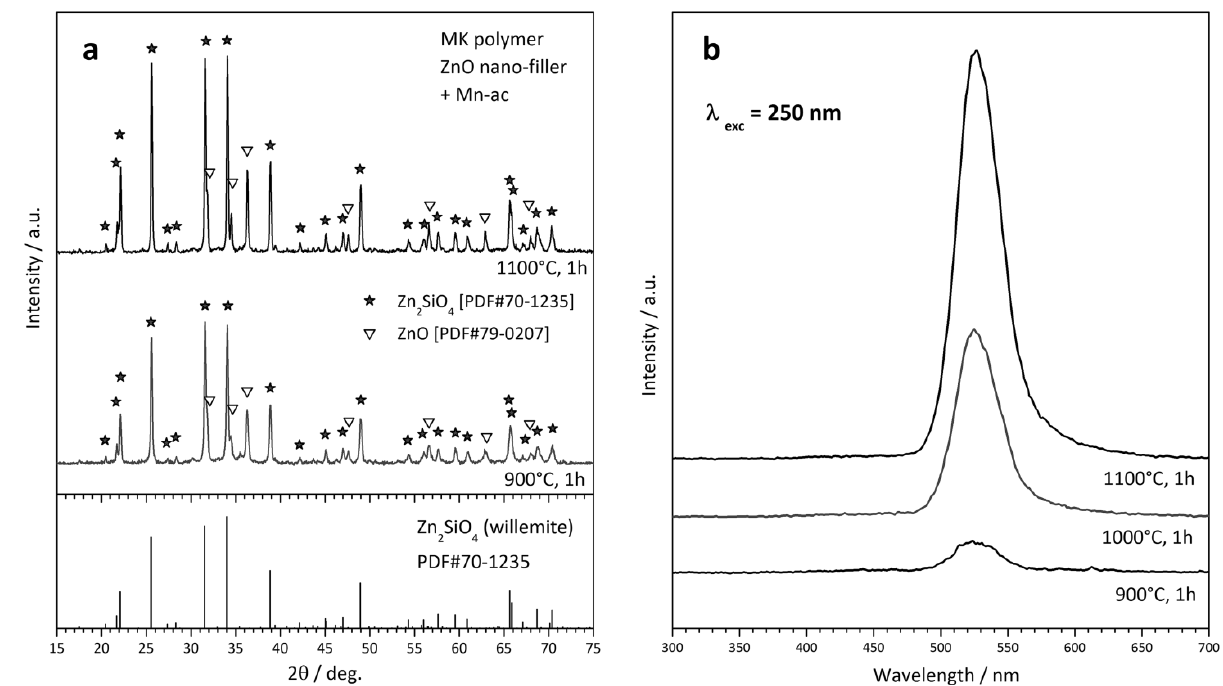
Figure 6. X-ray diffraction patterns ( a ) and luminescence spectra; ( b ) of polymer-derived Mn-doped zinc silicate